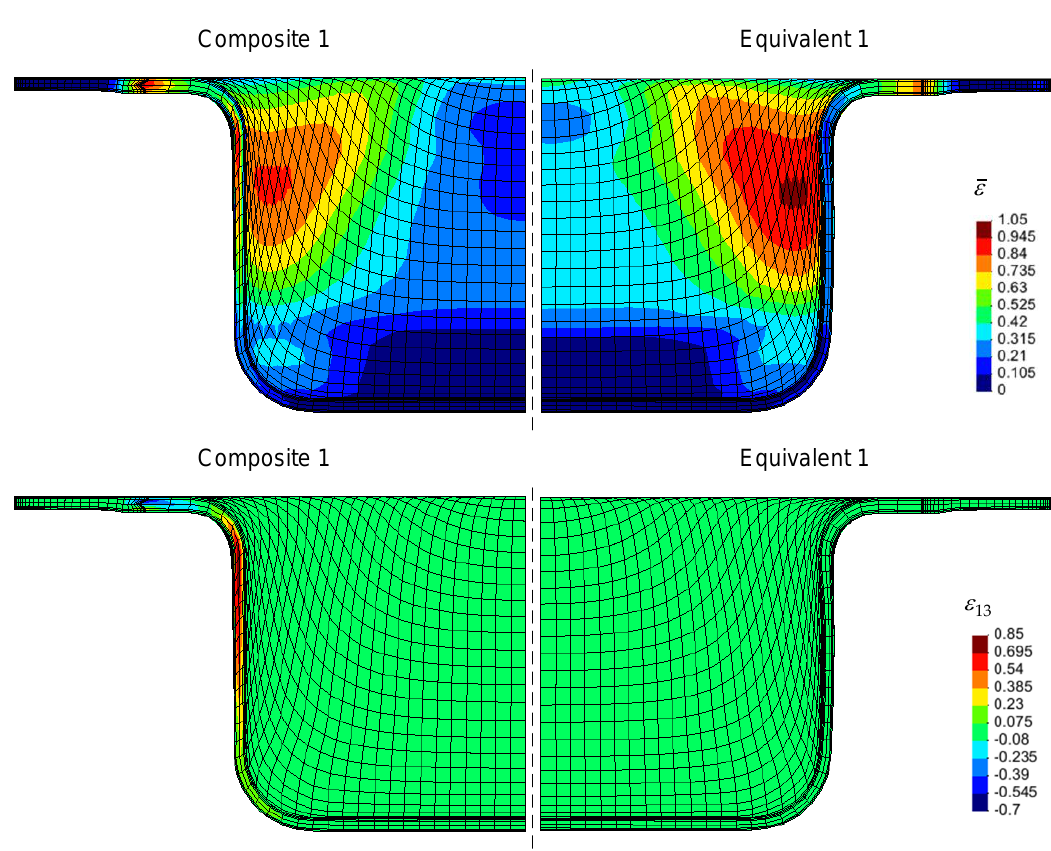
Figure 14. Side view of the equivalent plastic strain distributions, ε̅ , and Green–Lagrange shear strain, 𝜀 13 , in the Composite 1 and corresponding equivalent material, at the end of the deep drawing process for BHF = 19.6 kN. The maximum values of 𝜀̅ and 𝜀 13 are, respectively: 0.989 and 0.817 (for Composite 1); 1.038 and 0.073 (for Equivalent Composite 1).